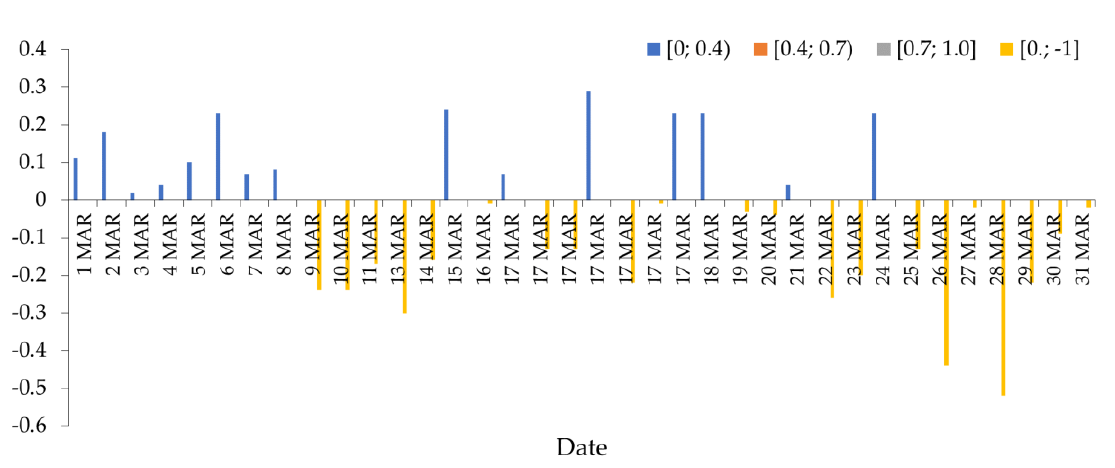
Figure 10. Pearson ’s correlation coefficients in relation to the peak discrepancies on 1 March and the peaks on other days. In 14 cases (40%), Pearson ’ s correlation coefficient for the peak discrepancies was >0.4, i.e., the relationship was good. In 19 cases (55%), the relationship was weak (<0.4), and only in two cases (5%) was the relationship negative. The groups of five cloud subsets were selected in Table S7 (and additionally two sub- sets before the peak and two after the peak from set 𝐵 ) in order to study the similarity of positioning discrepancy clouds. The intersection of subsets of stations was performed for the five-cloud group subsets on 1 March with 35 other corresponding five-cloud group subsets (Formula (11)). Two types of intersection results were required: (a) cardinality of intersection of the peak subset on March 1 and other peak subsets where the third subset of each group was a peak subset; (b) a percentage of the summarized resulting cardinality compared to the summarized cardinality of 1 March. The results are presented in Table S9 (with source data in Table S8) and the sample is shown below in Table 1.